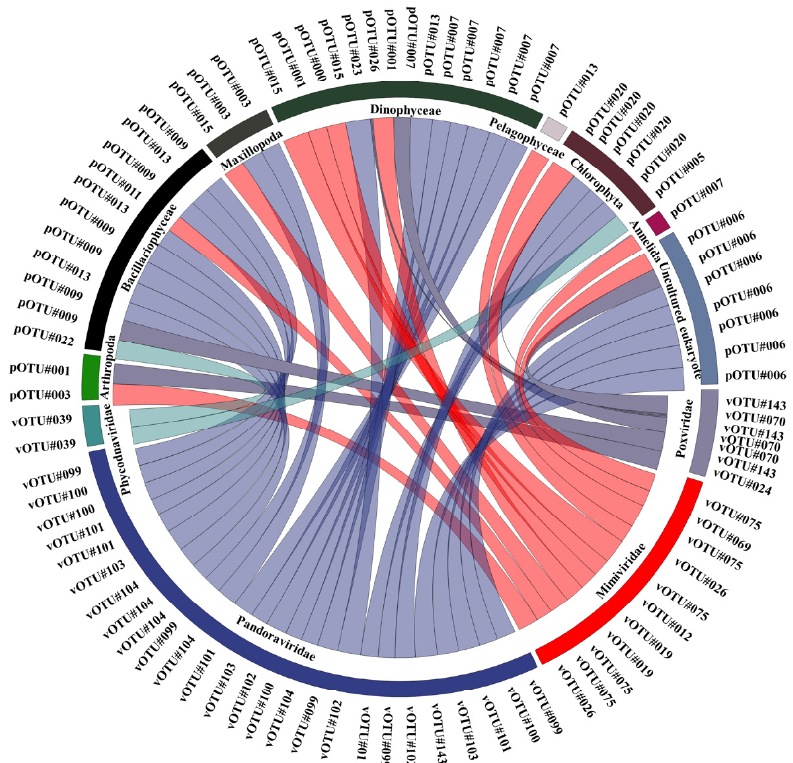
Figure 5. Associations between nucleocytoplasmic large DNA viruses (NCLDVs) and the eukaryotic plankton community (EPC) in the Sub–Arctic Kongsfjorden. Significant pairwise comparisons of the Pearson correlation coefficients between NCLDV and EPC lineages. Detailed information (species names of operational taxonomic unit [OTU] numbers and correlation coefficients) is described in Table